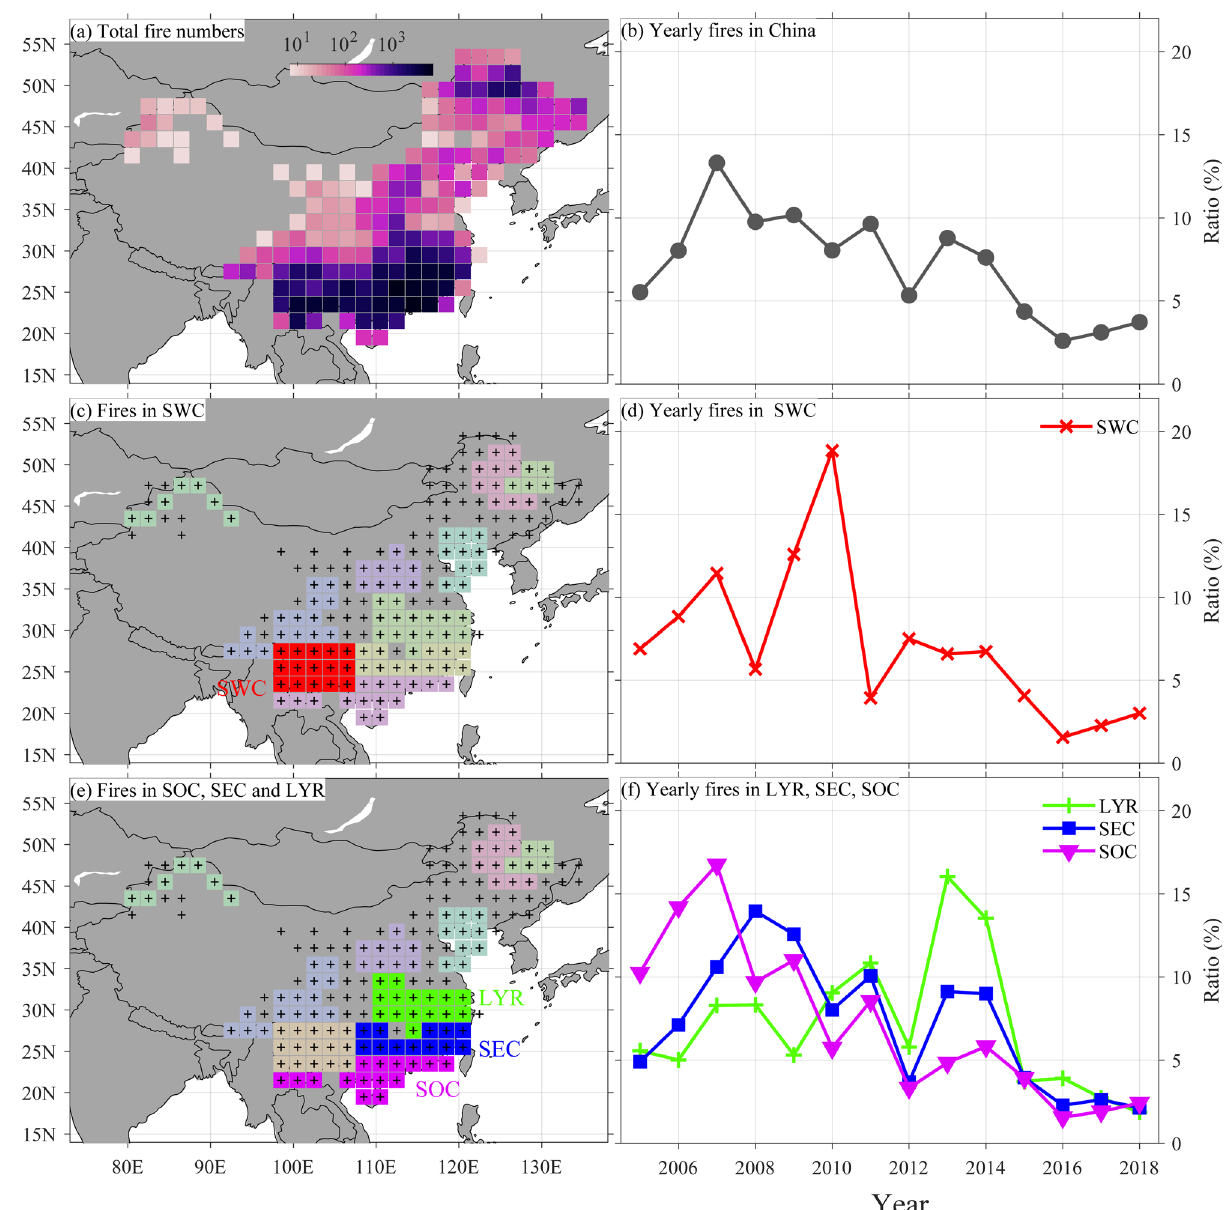
Fig. 1 Spatiotemporal fi re occurrences of the Wild fi re Atlas of China (WFAC). a Total WFAC fi re occurrences (2005 – 2018) in the 2 × 2° gridded network, the b time series of the annual percentage (percentage of all fi res (sum of gridpoint-level standardized fi re occurrences) in a given year) of the WFAC fi re chronology, the c location of the Southwestern China (SWC) fi re region, d the annual percentage of fi res of the SWC fi re chronology, the e location of Southeastern China (SEC), the Lower reaches of the Yangtze River (LYR), and Southern China (SOC), and f the annual percentage of fi res of the LYR, SEC, and SOC fi re chronologies. The other shaded fi re regions are shown in the Supplementary Fig.